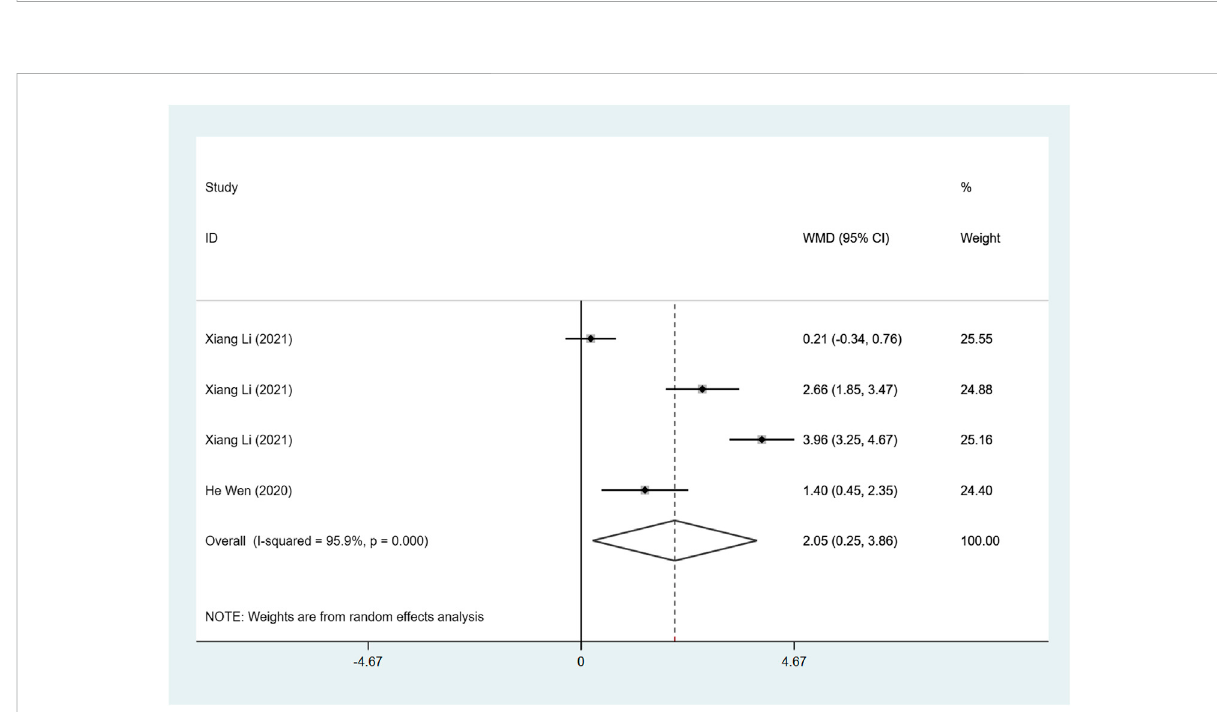
FIGURE 5 Forest plot of FS between sacubitril-valsartan and ACEI or ARB.